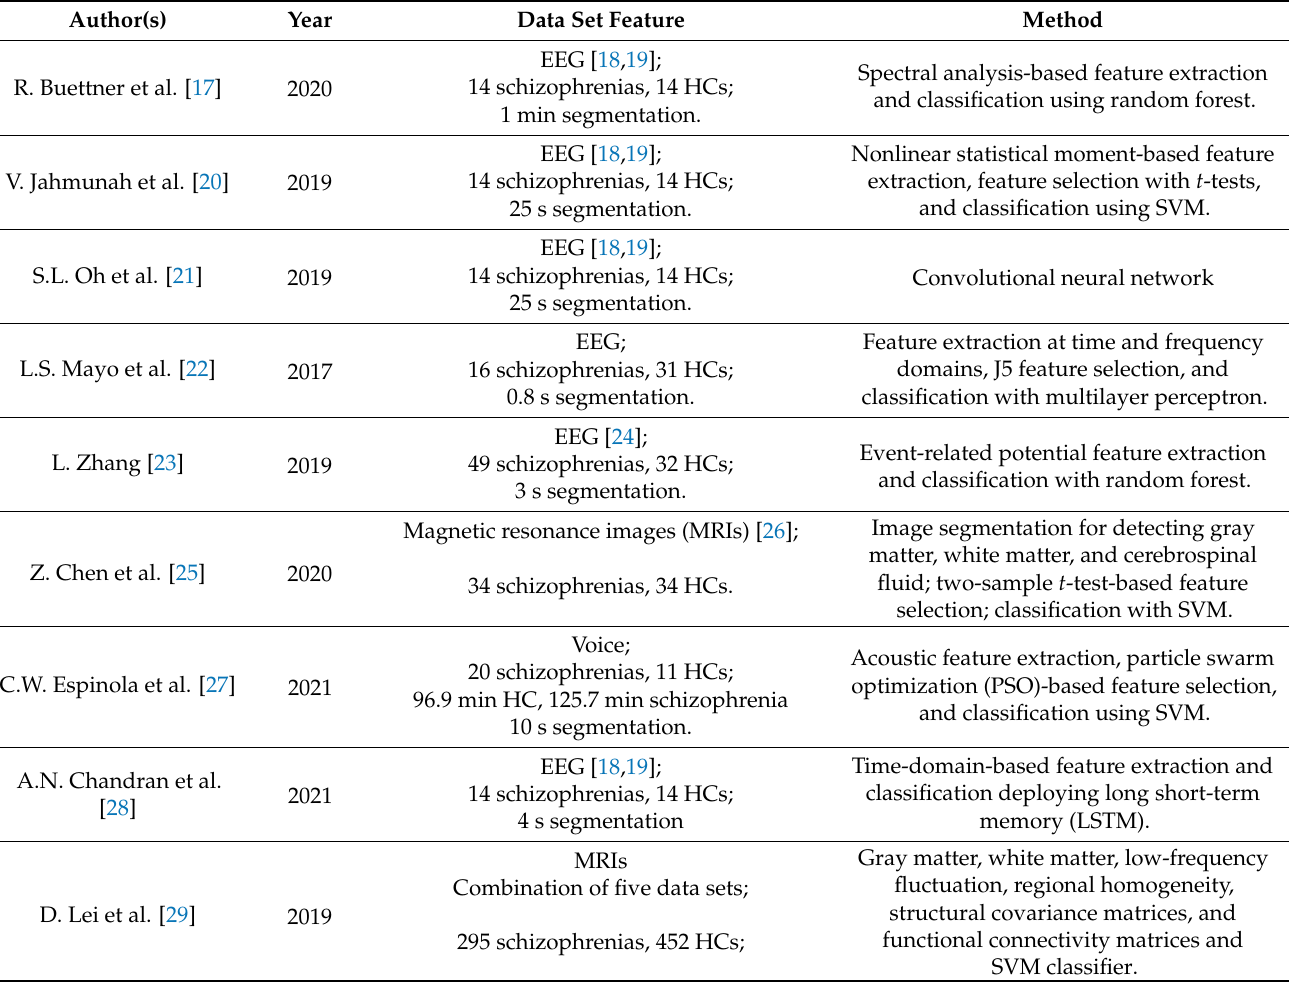
Table 1. Automatic SZ classification using ML